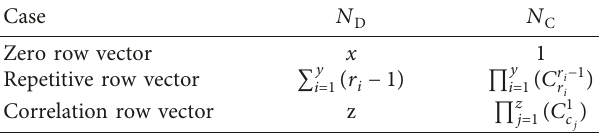
and N of three kinds of D C